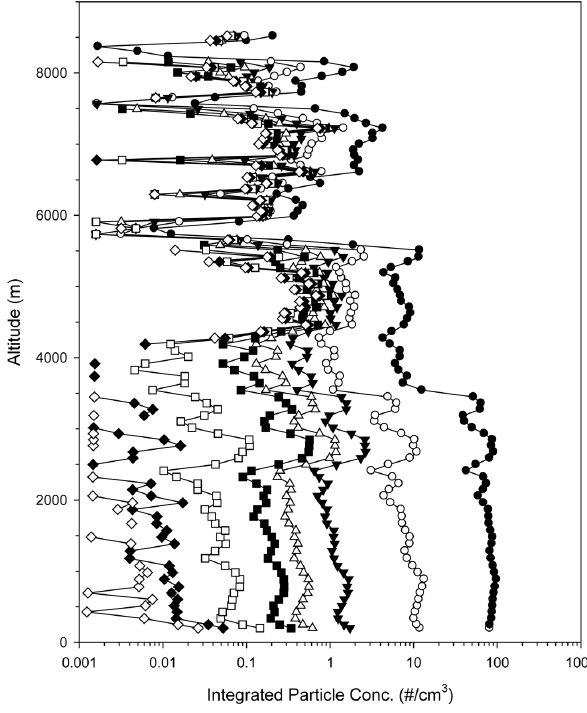
Fig. 5. Vertical profiles of aerosol concentration for eight size cri- teria observed with the OPC sonde, 19 April 2008. The horizontal axis represents the total number concentration larger than each size criteria shown in the legend.